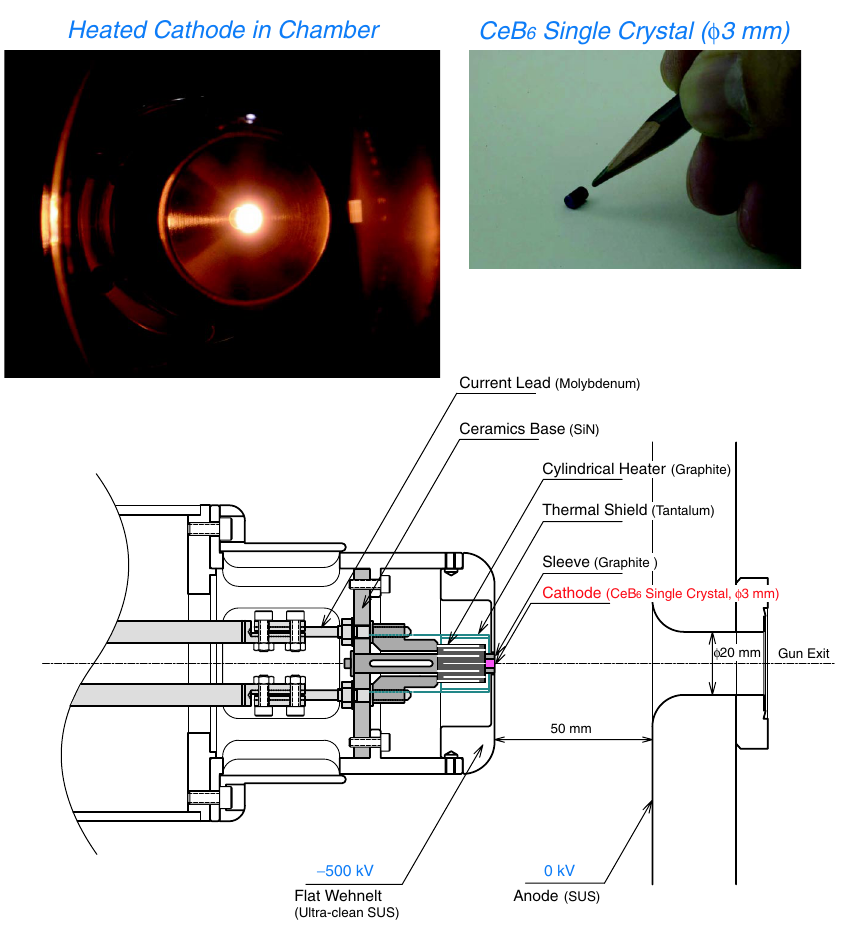
FIG. 2. (Color) CeB